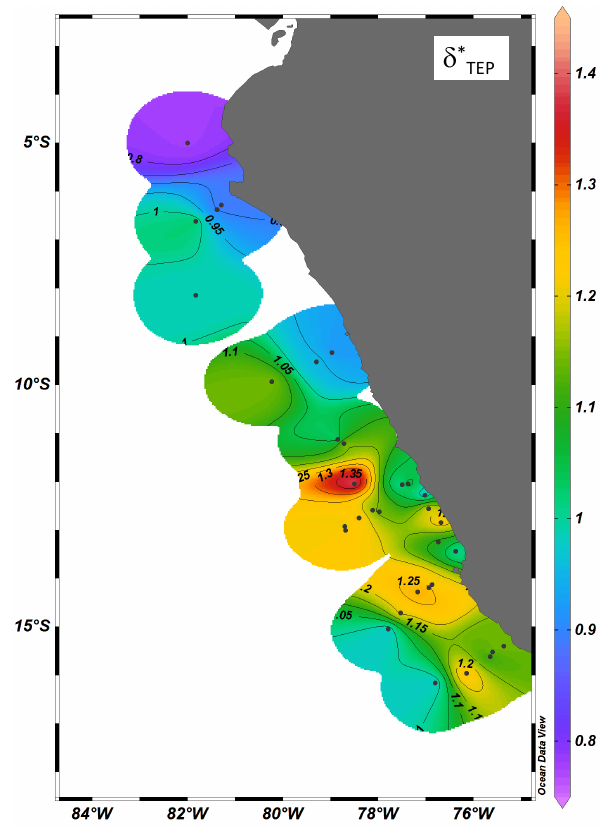
Figure 9. Spatial distribution of the slope ratio, δ ∗ , for TEP in the upwelling region off the coast of Peru during